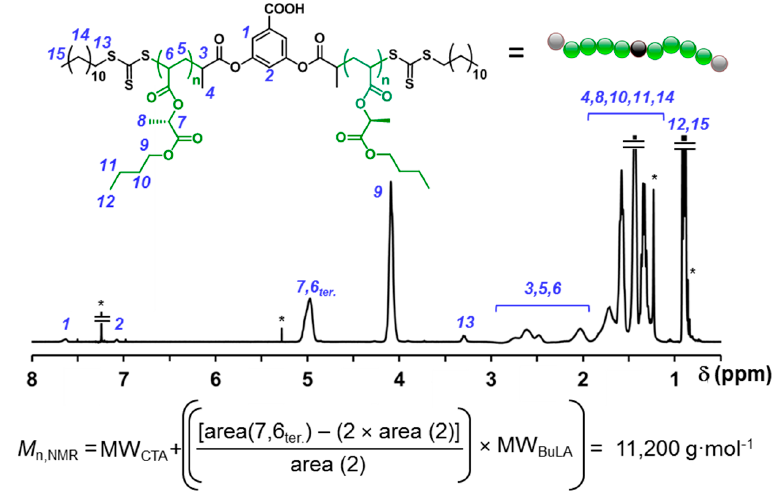
Figure 6. 1 H NMR spectrum PBuLA-2Z ( M n,GPC = 10,900, M w / M n = 1.24) in CDCl 3 . 1 H NMR resonances from “grease” impurities and residual solvents are indicated with *.